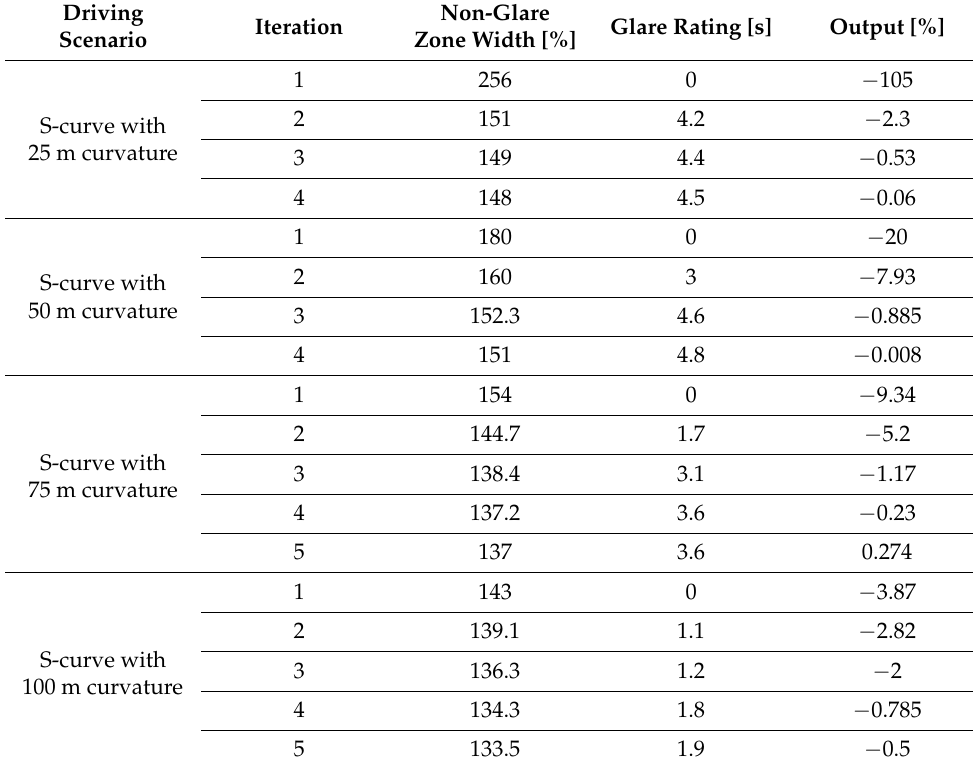
Table 4. Trial 1 iteration of four driving scenarios, using the fuzzy logic controller with linear membership